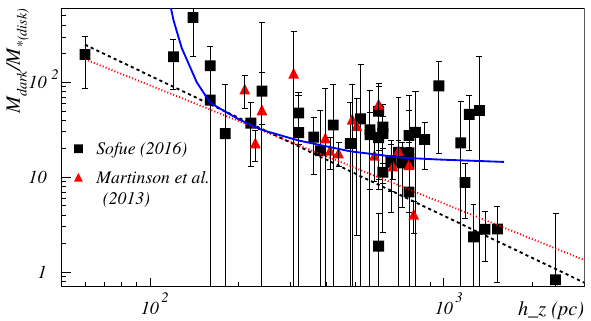
Fig. 6 Galactic dark mass M dark normalized to baryonic disk mass vs. vertical scale length h z . The squares show the data from Ref. [22] and triangles from [23]. M dark / M ∗ correlates with h z . The dashed and disk dotted lines give the best fit to Refs. [22,23], respectively, assuming a ah b z form. The plain line is the lensing calculation described in this